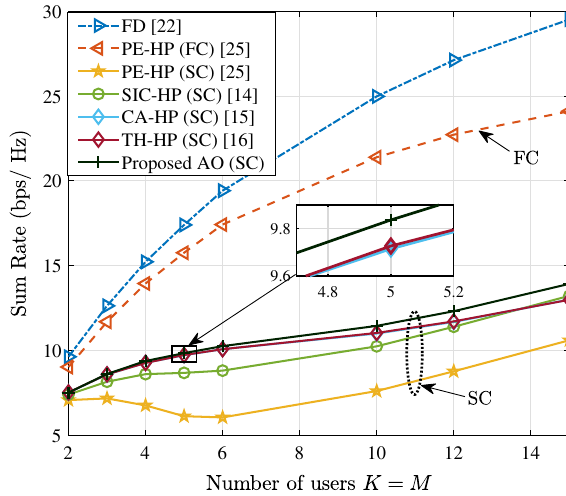
Fig. 4 Sum rate versus number of users K . We set N t = 60 , M = K , and SNR = 0